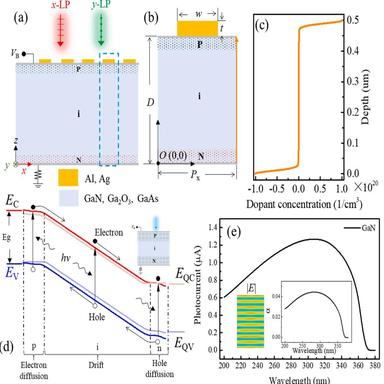
(a) Schematic diagram of MGPIN, (b) parameters in a unit cell, (c) doping profile of the semiconductor (p- and n-) layers, (d) energy band diagram and (e) photocurrent of the pure GaN PiN structure.